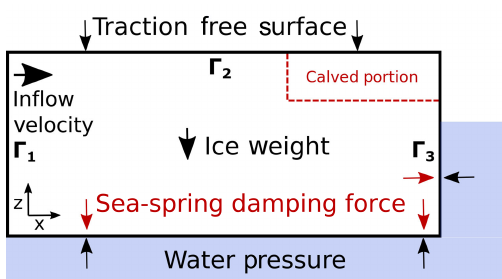
Figure 1. A diagram showing the boundary conditions of an ide- alized floating ice shelf. The ice–ocean interface is subject to two normal stresses – the depth-dependent water pressure and the nu- merical damping force for stabilization to hydrostatic equilibrium. The dashed red line illustrates an iceberg that breaks off from the top of the calving front (exaggerated), reducing the freeboard and instantaneously perturbing the ice shelf from hydrostatic equilib-